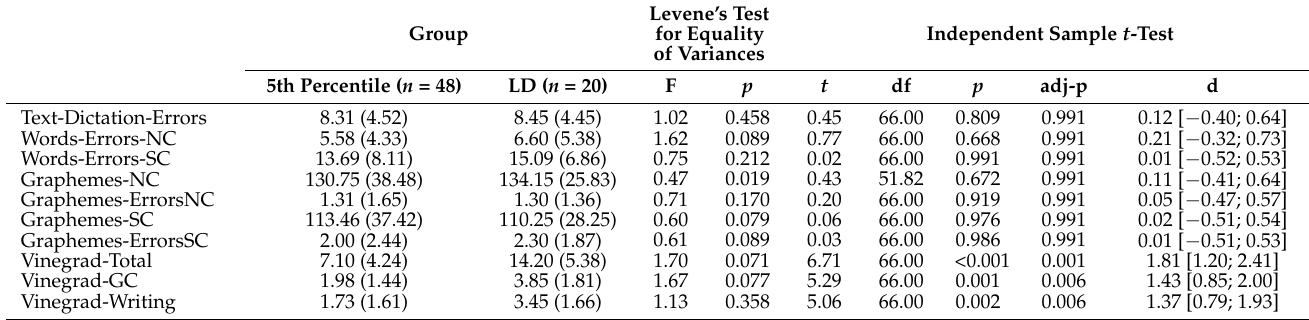
Independent Sample t